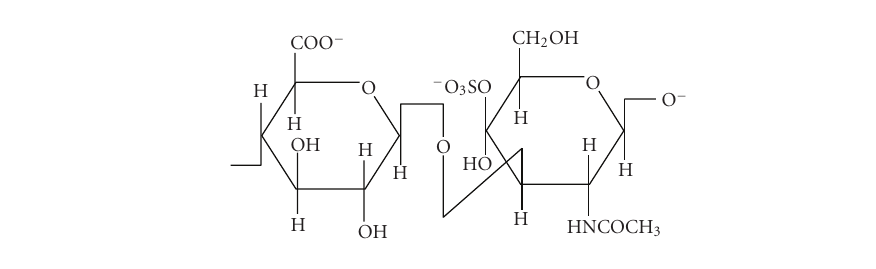
Figure 2: Structure of di ff erent kinds of GAG disaccharides of physiological